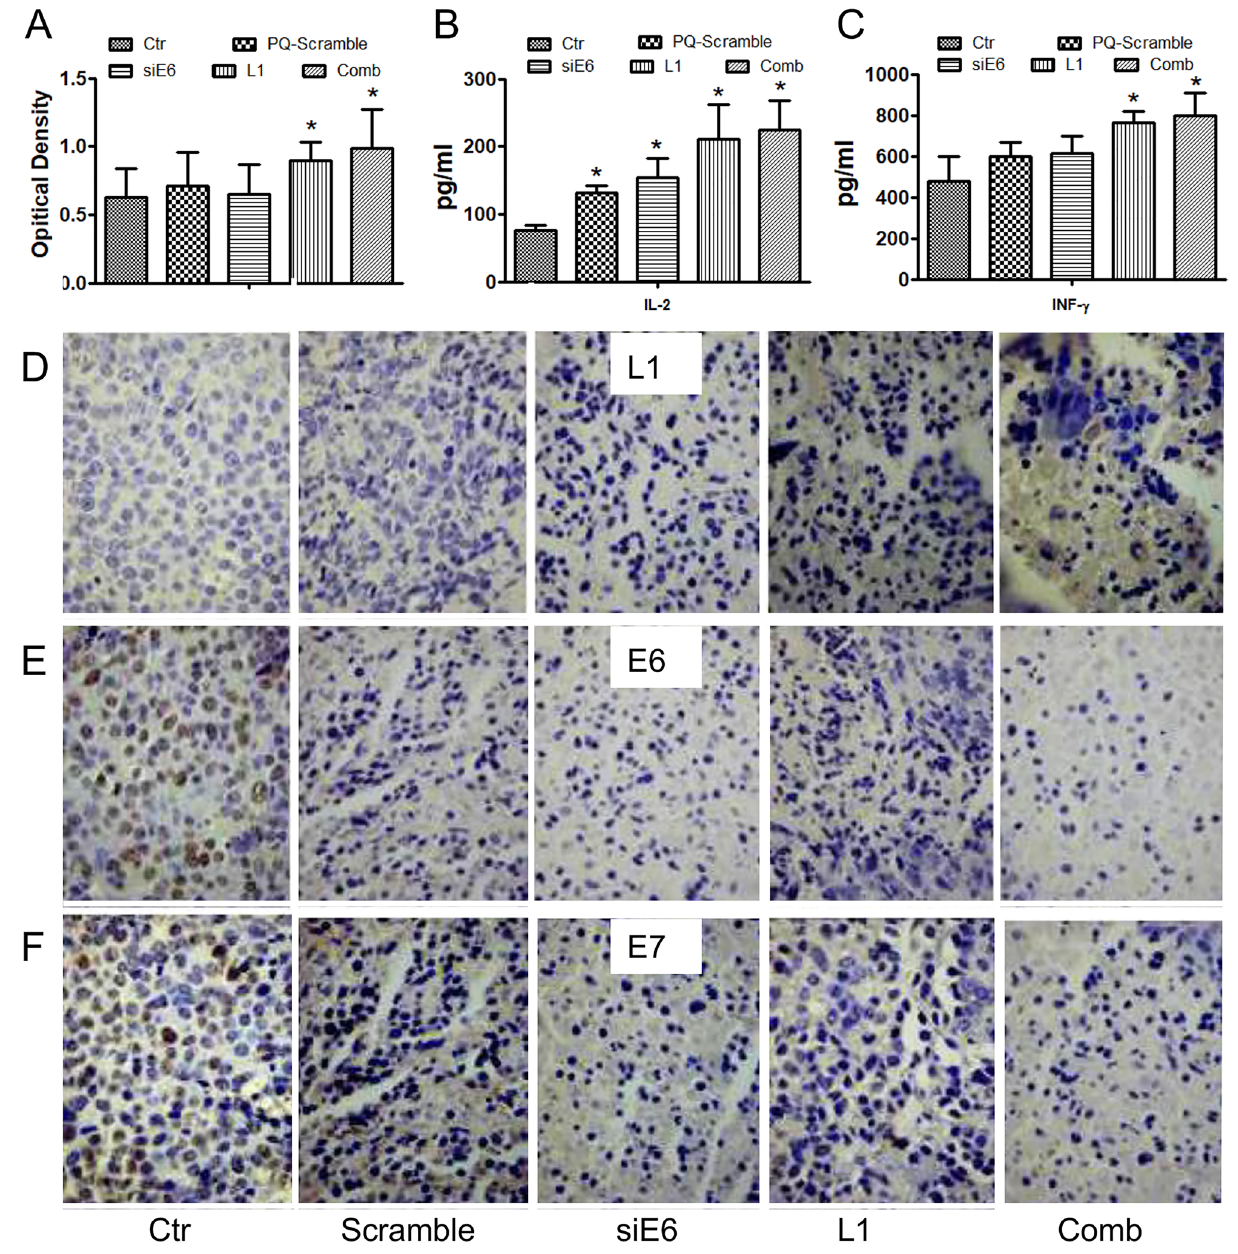
Figure 7. The mechanism of phoP/phoQ(pcDNA3.1-L1-siE6) inhibiting the growth of xenograft tumors in vivo. ( A ) ELISA analysis of anti-HPV16-L1 antibody in serum after treated with phoP/phoQ. *P < 0.05, vs the control group. ( B , C ) ELISA anal-ysis of IL-2 and IFN-γ in serum after treated with phoP/phoQ. *P < 0.05, vs the control group. ( D – F ) Immunohistochemical analysis of HPV-L1/E6/E7 protein expression in Siha xenografts treated with phoP/phoQ (×